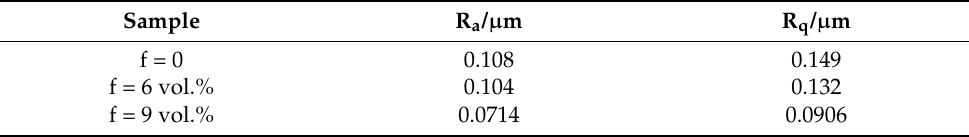
Table 5. Roughness parameters of the surface erosion